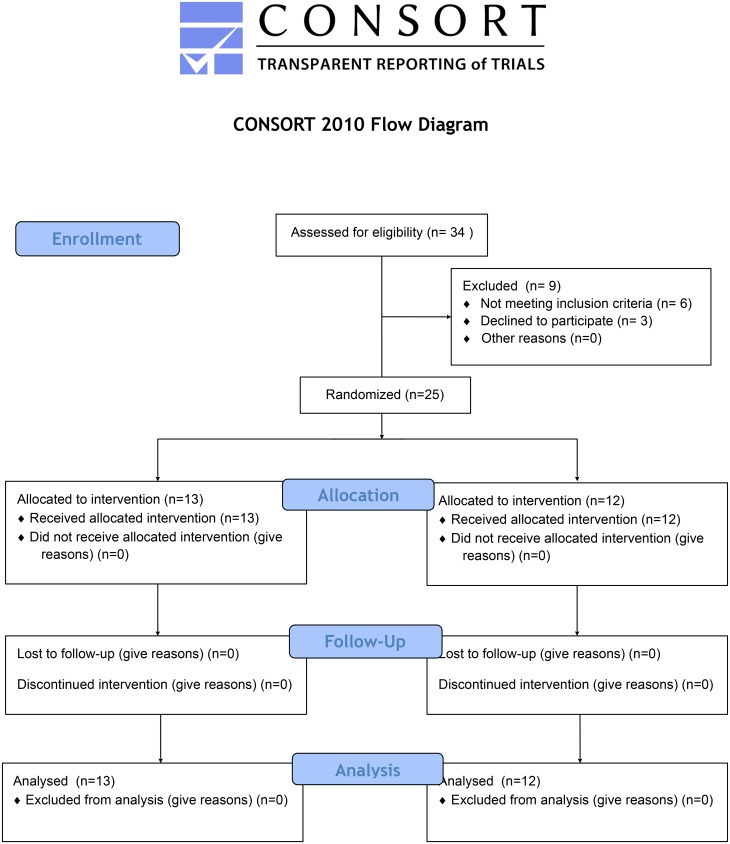
Consort diagram.